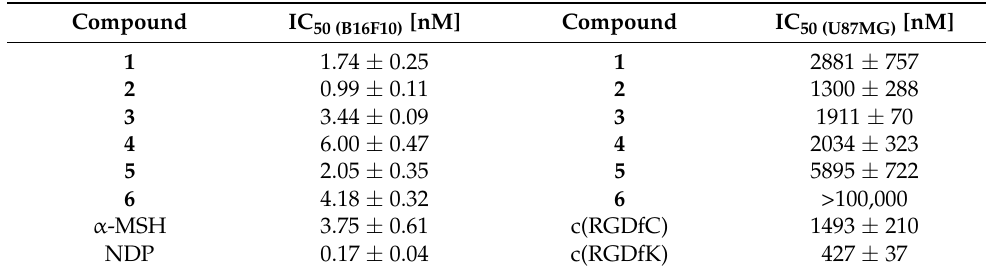
Figure 5. Depiction of the determined binding curves of the HBPLs 1 – 6 , obtained by competitive displacement assays on MC1R-positive B16F10 cells ( A ) and integrin α v β 3 -positive U87MG cells ( B ). Values are depicted as mean ( n = 9); error bars represent SD. Table 2. Summary of the IC 50 values determined for the HBPLs 1 – 6 by competitive displacement studies on MC1R-positive B16F10 cells and integrin α v β 3 -positive U87MG cells. Values are given as mean ±